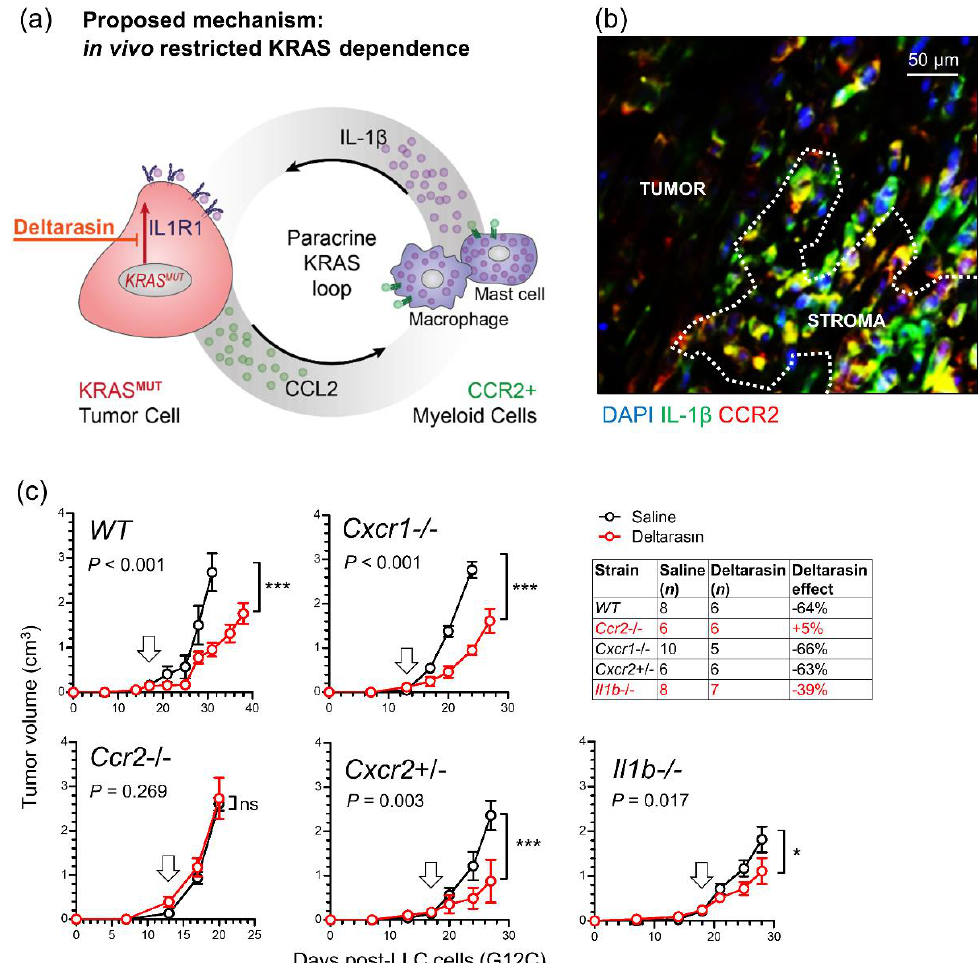
Figure 5. A requirement for host Ccr2 and IL1b for KRAS dependence in vivo. ( a ) Graphical scheme of the proposed mechanism of in vivo restricted KRAS dependence. ( b ) Representative image of CCR2/IL- 1β -co-staining of a KRAS -mutant tumor from a Rag2 −/− mouse showing co-localization of the two proteins in the tumor stroma. Image was taken using an AxioImager.M2 (Zeiss; Jena, Germany) with a 60× objective. ( c ) Syngeneic C57BL/6 mice competent ( WT ) or deficient ( Il1b −/− , Ccr2 −/− ) [18,20] in the Il1b and Ccr2 genes or haplo/diplo-insufficient in the Cxcr1 and Cxcr2 chemokine receptor genes ( Cxcr1 −/− , Cxcr2 +/− ) received 10 6 LLC cells ( Kras G12C ) sc followed by daily ip saline (black) or 15 mg/Kg deltarasin (red) treatments initiated when tumors reached 100 mm 3 volumes (arrows). Data are presented as mean ± SD. p , overall probabilities according to two-way ANOVA; ns, *, and ***: p > 0.05, p < 0.05, and p < 0.001 for the indicated comparisons via Bonferroni post-tests. Table shows animal numbers used and percentile tumor inhibition by deltarasin compared with saline. Ccr2 , C-C motif chemokine receptor; IL- 1β, interleukin -1 beta; Cxcr1/Cxcr2 , C-X-C motif chemokine receptor 1/2.